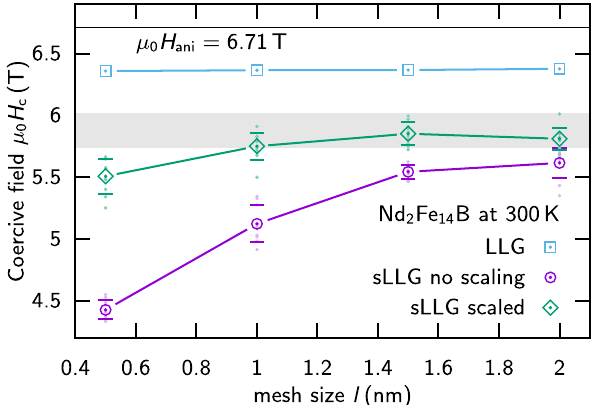
Fig. 6 Coercive fi eld test. Coercive fi eld of a hard magnetic 10 nm cube calculated with a fi eld sweep rate of v = 250 mT ns − 1 . The anisotropy fi eld is μ 0 H ani = 6.71 T. Conventional, non-thermal LLG gives a mesh independent coercive fi eld of 6.36 T, reduced from the anisotropy fi eld by the magnetostatic fi elds. Unscaled sLLG produces a coercive fi eld heavily dependent on the mesh size, and outside the gray band of theoretical expectations in the entire mesh-size range. In contrast, FUSSS LLG greatly reduces the mesh- size dependence and produces a coercive fi eld that is inside the gray band of expectations for most mesh sizes. The error bars show the standard deviation, and the symbols show the mean of ten independent stochastic